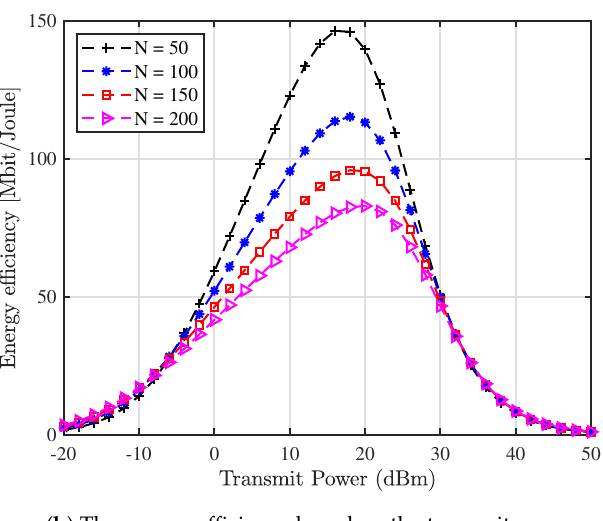
Figure 10. The achievable rate and the energy efficiency based on the transmit power with different IRS